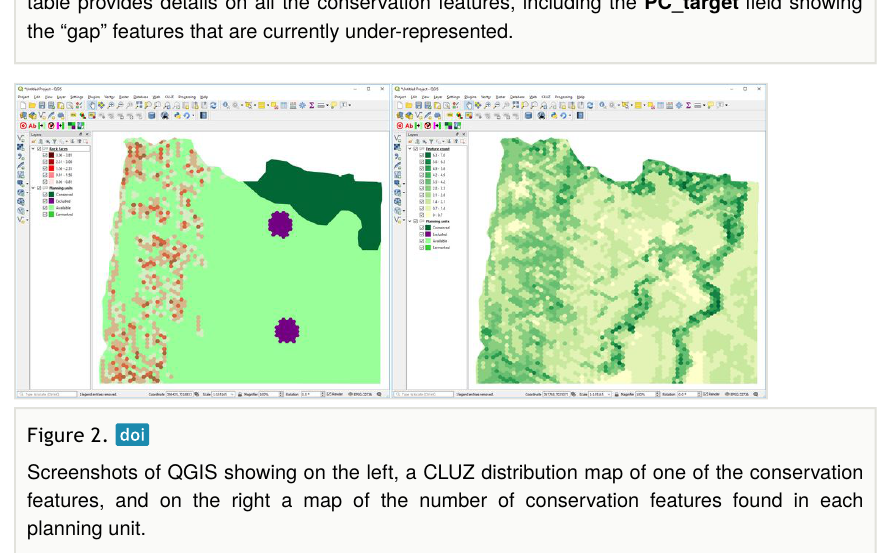
Screenshot of QGIS showing the planning units layer and CLUZ target table. The CLUZ target table provides details on all the conservation features, including the PC_target fi eld showing the “gap” features that are currently under-represented.